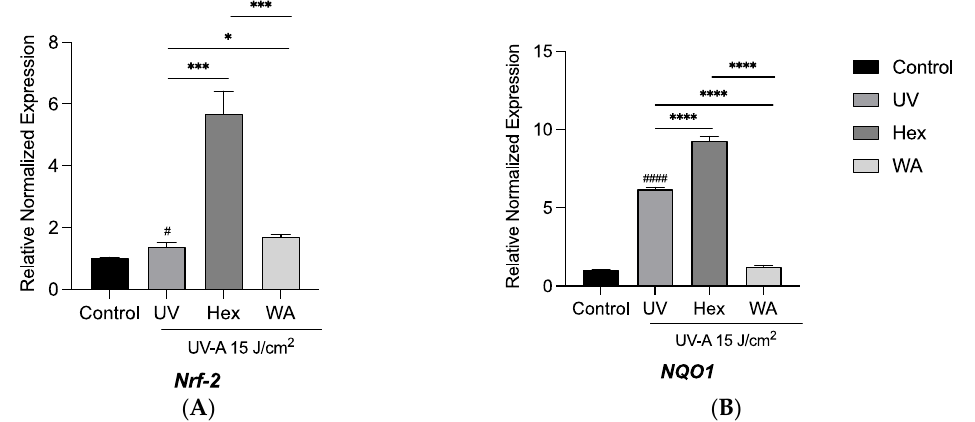
Figure 7. Effects of fractions of fermented turmeric milk on antioxidant genes expression in UVA- exposed Hs68 cells. ( A ) Nfr-2 , ( B ) NQO1 . Control: group without UV-A irradiation; NC: irradiated with 15 J/cm 2 without other treatment; NAC: 1 mM N-acetylcysteine; Hex: 100 ppm n-hexane extract of fermented turmeric milk; WA100: 100 ppm fermented turmeric drink water. Residual layer test results are repeated three times and expressed as mean ± standard deviation. Statistics were analyzed by t -test, # = p < 0.05 vs. Control, #### = p < 0.0001 vs. Control, * = p < 0.05, *** = p < 0.001, **** = p < 0.0001.